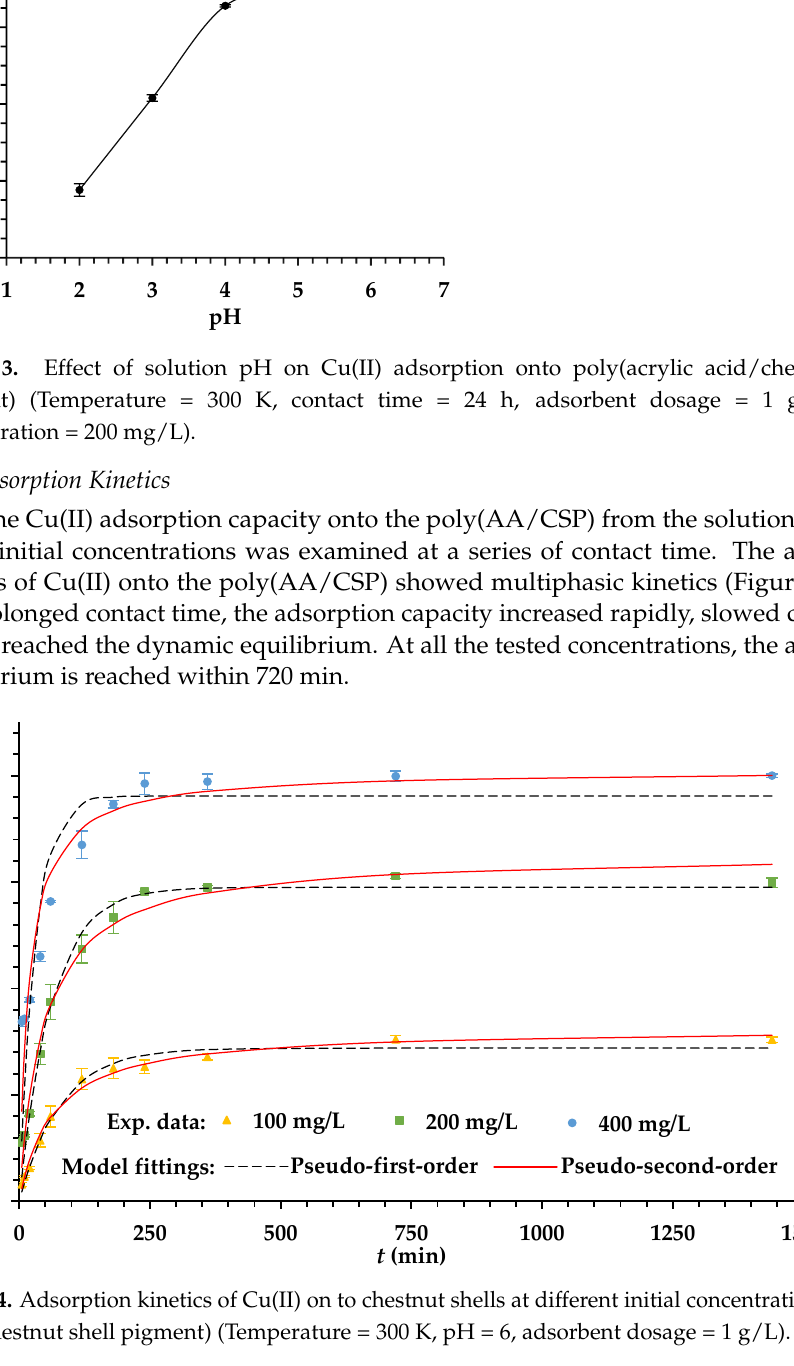
Table 1. Kinetic parameters of Cu (II) adsorption onto poly(acrylic acid/chestnut shell pigment) at temperature = 300 K, pH = 6, and adsorbent dosage = 1 g/L. C 0 (mg/L)